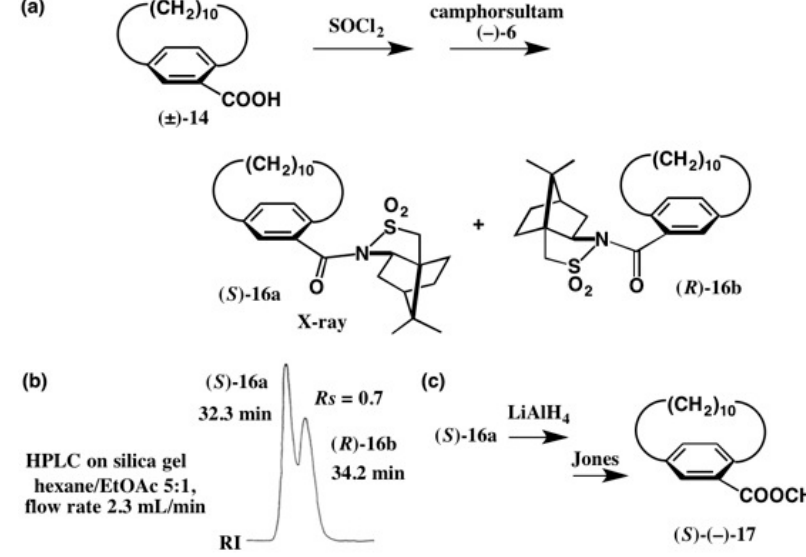
Figure 12. Preparation of diastereomeric amides 16a and 16b ( a ), separation by HPLC on silica gel ( b ), and preparation of methyl ester ( S )-( − )- 17 ( c ). HPLC, redrawn from [24].